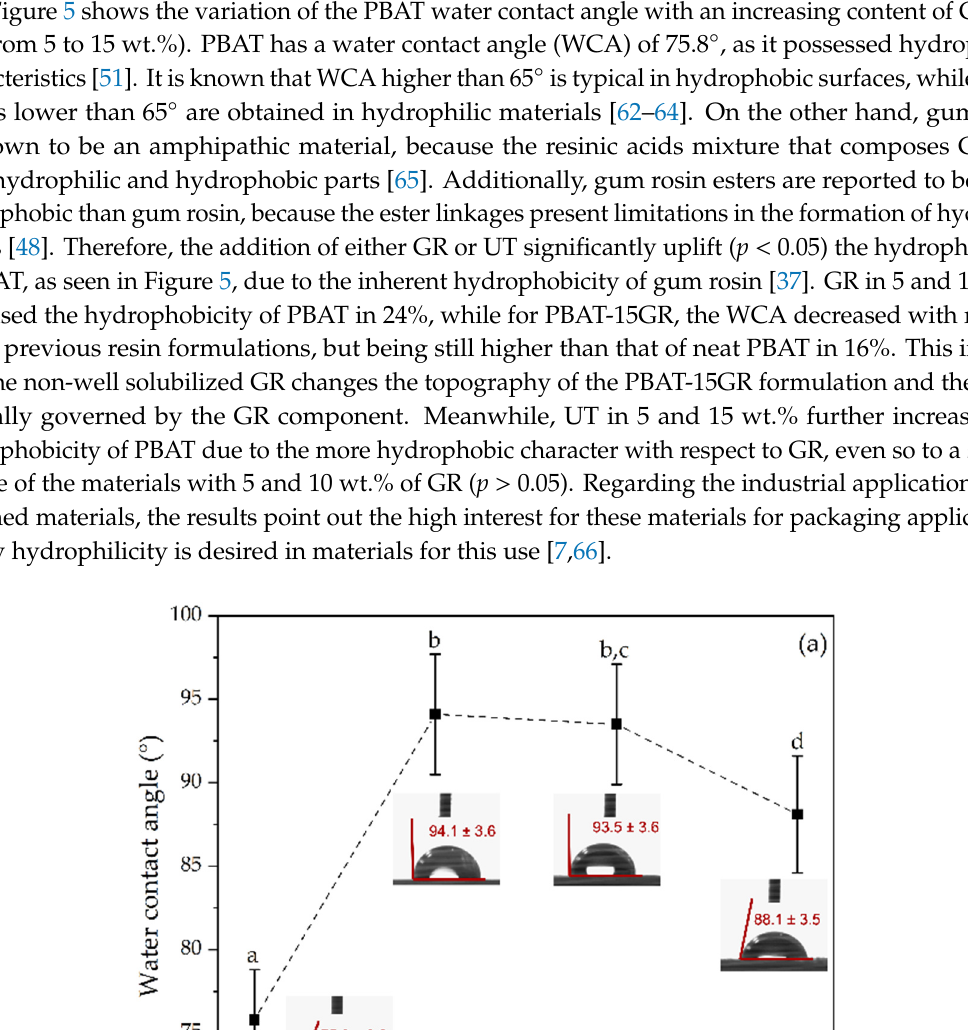
Figure 5. Variation of PBAT water contact angle as function of resin content ( a ) GR and ( b ) UT resin. a–d Different letters show statistically significant differences between formulations ( p < 0.05). 3.7. Colour Characterization Table 2 summarizes the colour coordinates of PBAT and PBAT resin-based formulations. The colour characterization reveals that GR and UT significantly reduce the lightness, L*, of PBAT ( p < 0.05) with the increase in the resin content. Additionally, GR reduces the lightness to a greater degree than UT because its natural colouration is stronger. Regarding the a* coefficient, a significant increase is seen as the content of GR increases, pointing out that GR provides a reddish colouration to the material with respect to neat PBAT [67]. On the contrary, UT did not significantly change the a* coefficient of PBAT ( p > 0.05). The b* coefficient significantly increases with the addition of both GR and UT ( p < 0.05), which indicates that the material acquires a yellowish hue [67]. Consequently, the yellow index (YI) presents the same behaviour as b*. Again, PBAT-GR formulations present higher values of YI than PBAT-UT formulations due to the colouration differences of both additives.